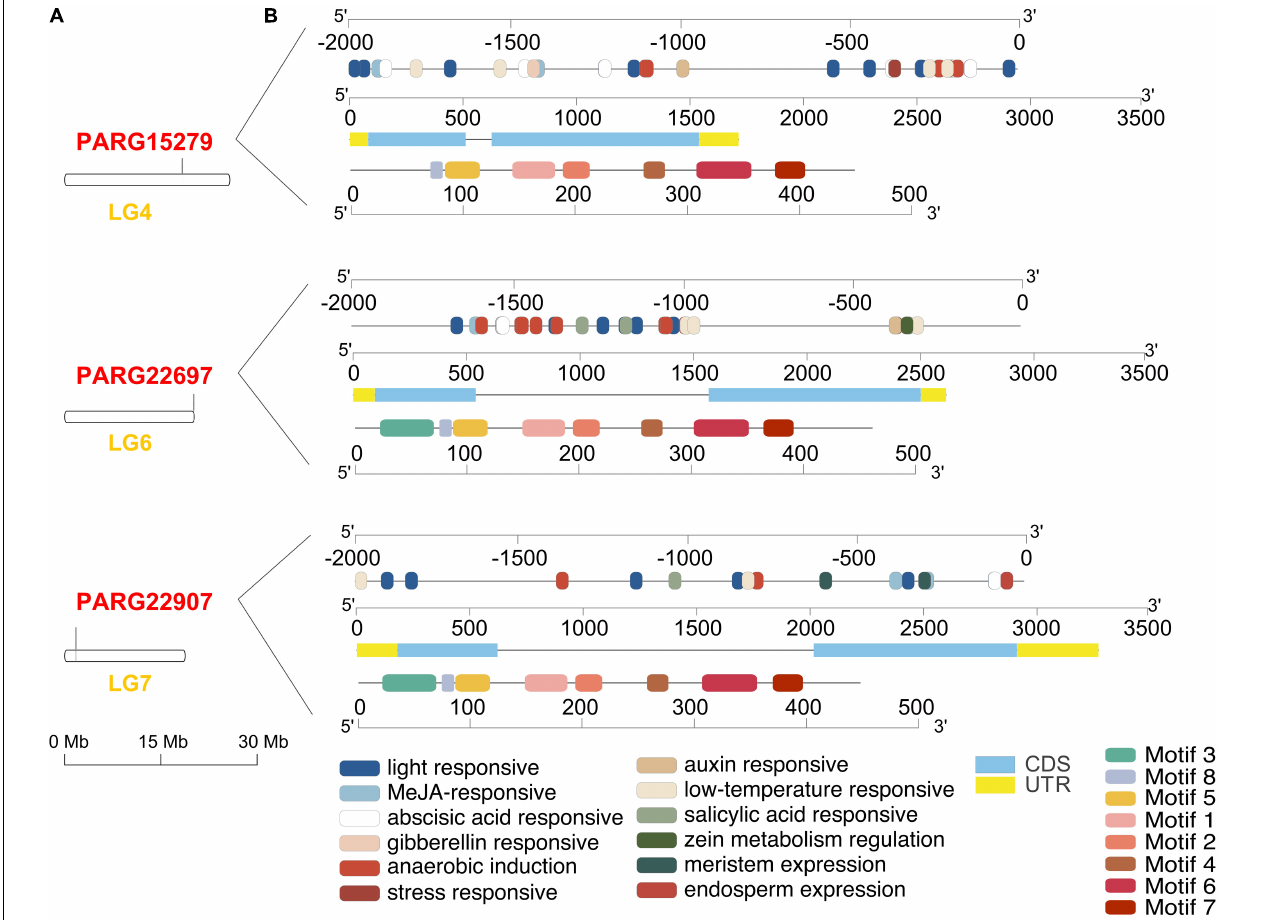
Frontiers in Plant Science |